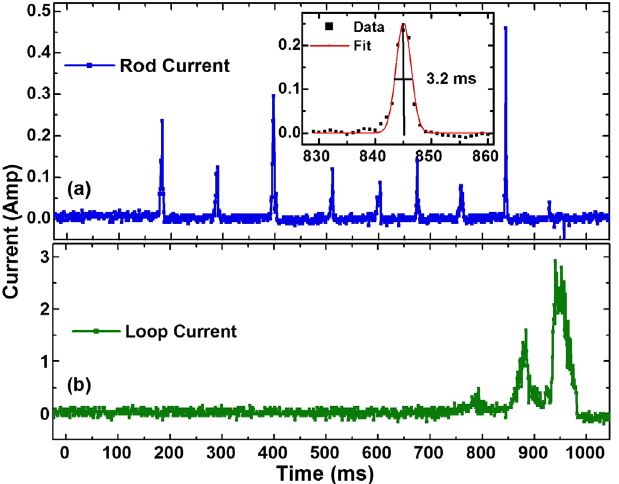
FIG. 3. Typical data from an arc pulse: (a) the data from the biased rod, and (b) from the biased loop. The inset in (a) is a two- point average of the rod current data around the peak at 845 ms with peak fitting.